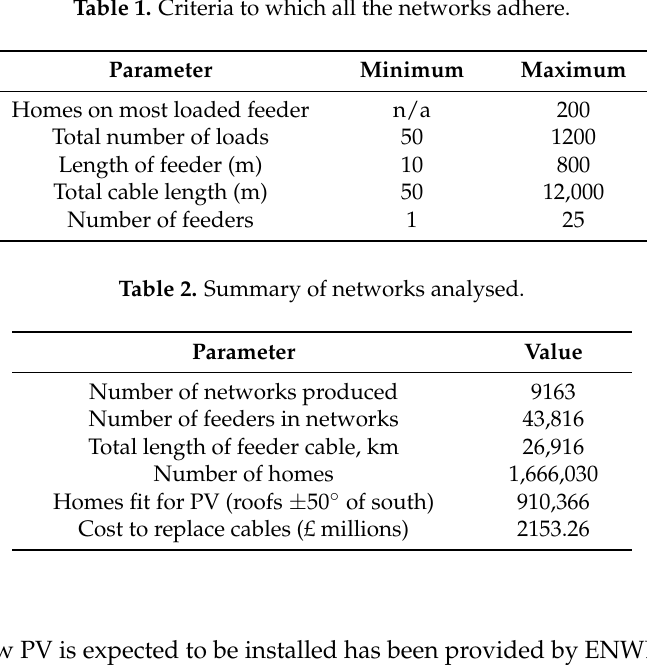
Table 1. Criteria to which all the networks adhere.